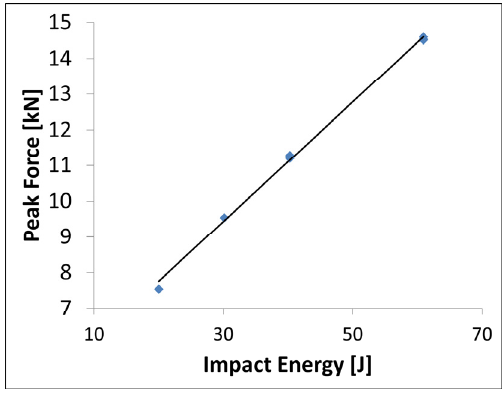
Figure 12. Peak forces over impact energies of the tested specimen.